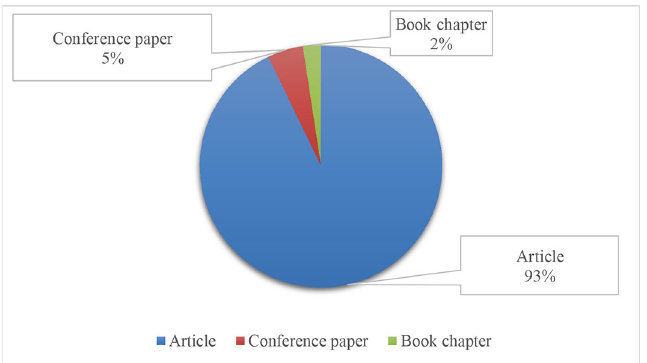
Figure 3. Types of publications.